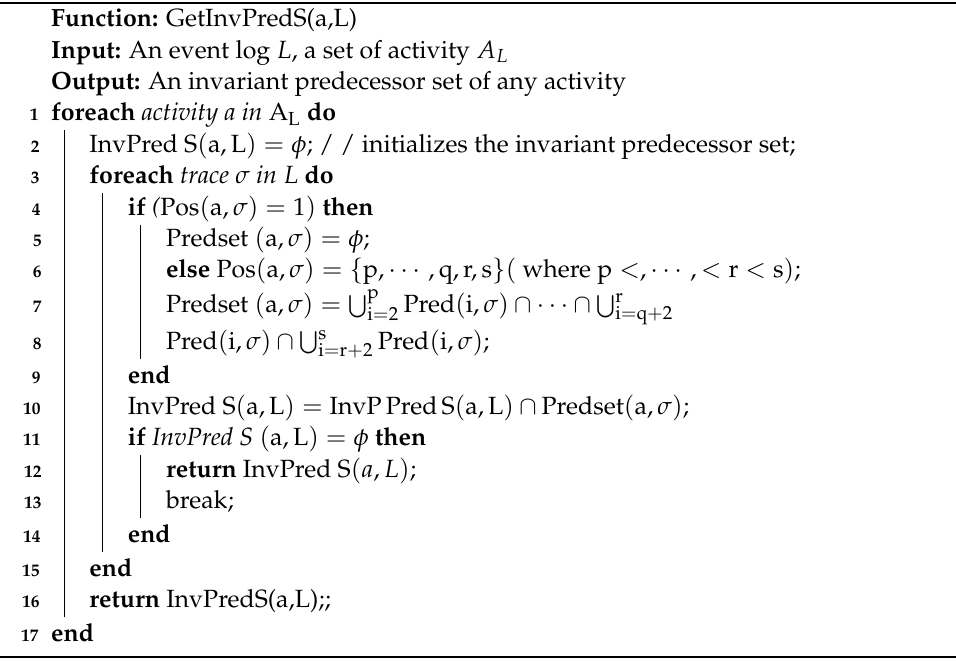
Algorithm 1: An invariant predecessor set of any activity